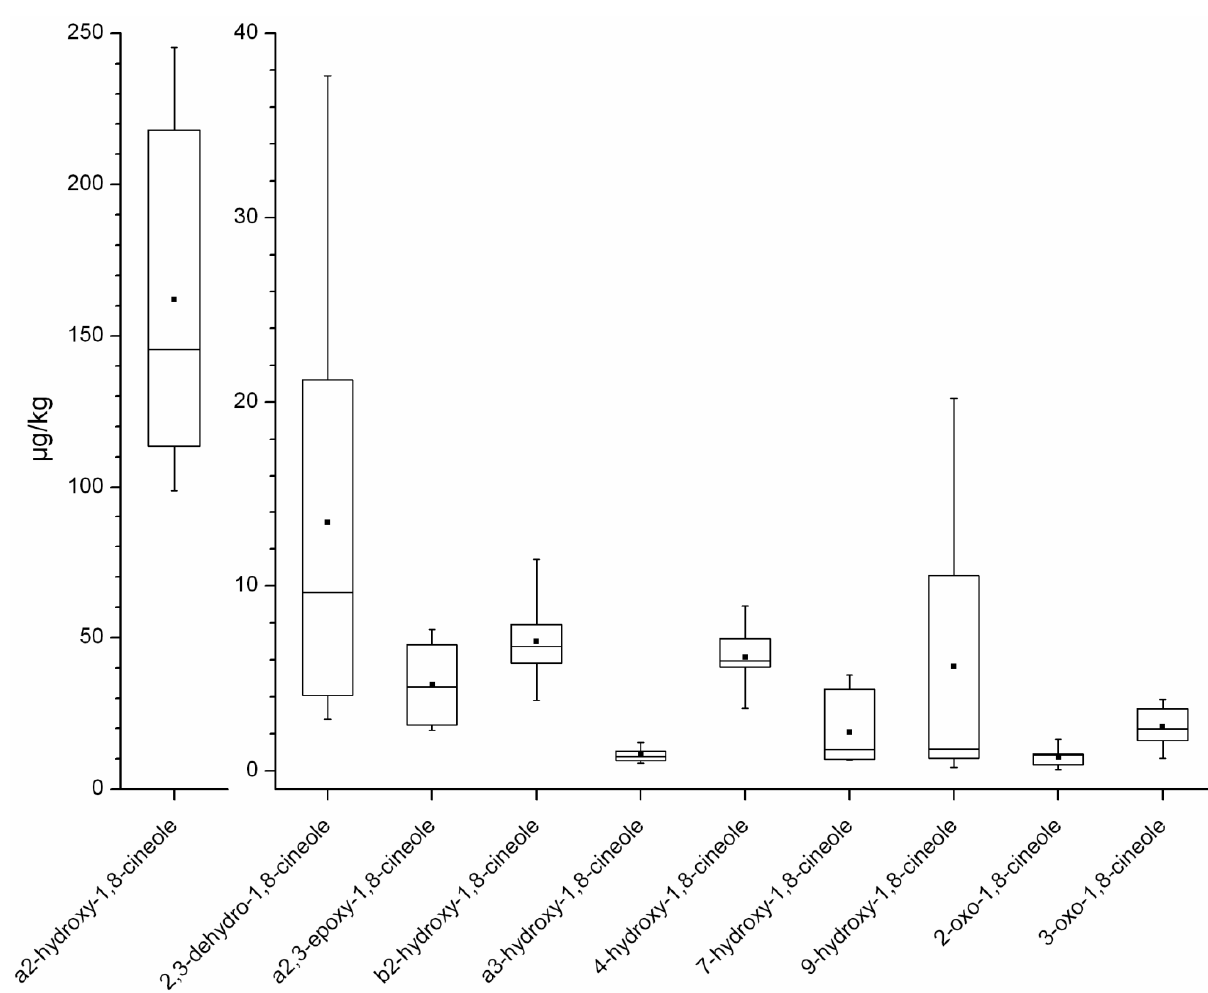
Figure 2. Boxplot of concentrations of metabolites of 1,8-cineole in human milk samples with eucalyptus-like